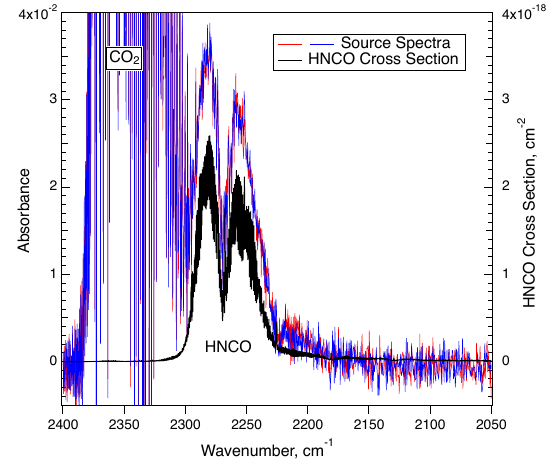
Fig. 6. Two consecutive Infrared spectra of the HNCO source out- put (red, blue) and the reference spectrum from the PNNL database (black).